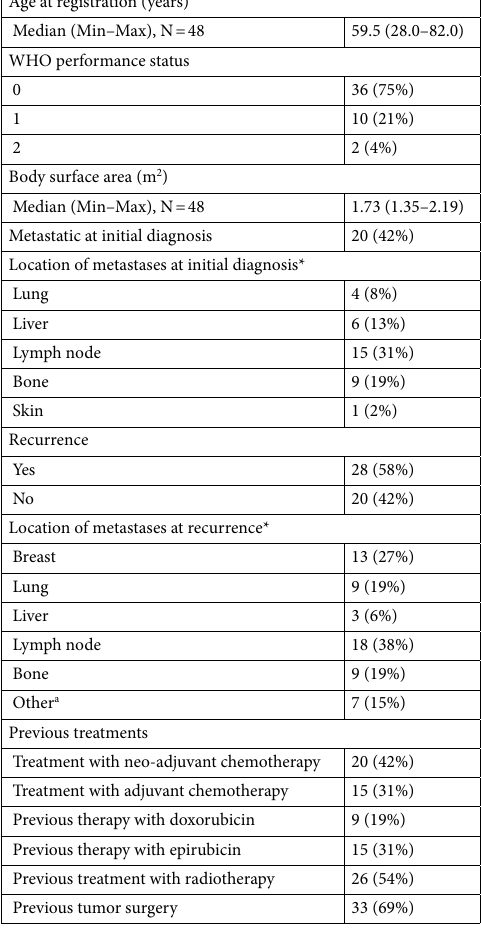
Table 1. Patients’ characteristics. Complete cohort of 48 patients. *More than one location is possible. a Other locations of metastases at recurrence were M. latissimus dorsi right, skin, mastectomy site, pancreas, peritoneal carcinomatosis, peritoneum, skin, soft tissue tumor component in the area of the sternum, chest wall soft